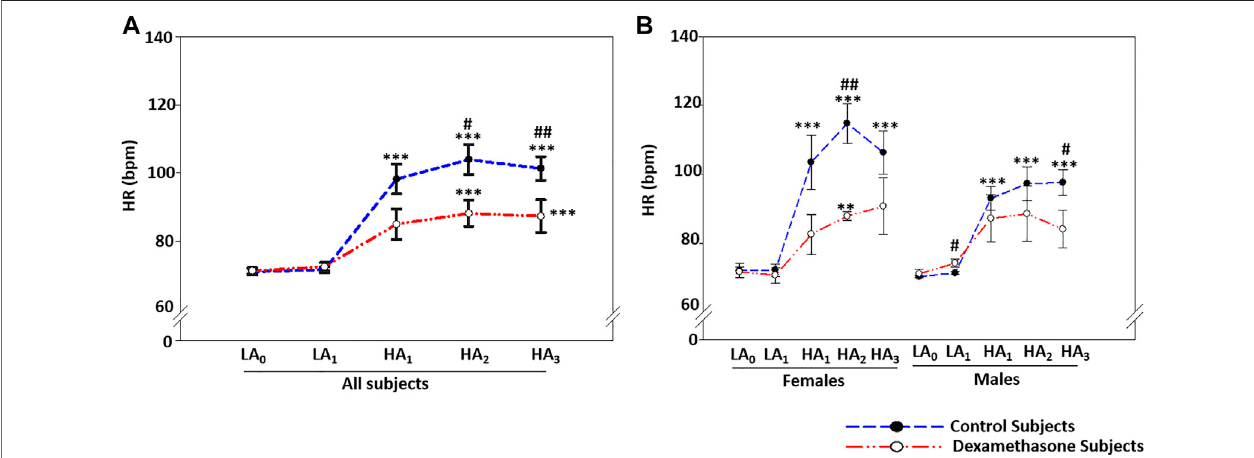
FIGURE2| Dexamethasonemediated-HRcontrolatHAwasmoreevidentinwomen. (A) DexamethasonecontrolledHR-elevationatHAby~14.7 bpmcompared to controls. (B) Dexamethasone controlled HR-elevation at HA in women by ~20.9 bpm and in men by ~10.3 bpm compared to elevation in the respective control groups. Data are presented as mean ± SE and are compared by one-way ANOVA. */ # p < 0.05, **/ ## p < 0.01, and ***/ ### p < 0.001 were considered statistically signi fi cant. * represents signi fi cance within each group compared to respective control at day 0 at LA, while # represents signi fi cance between the control group and dexamethasone group for the respective time point. HA 1 , day 1 at high-altitude; HA 2 , day 2 at high-altitude; HA 3 , day 3 at high-altitude.